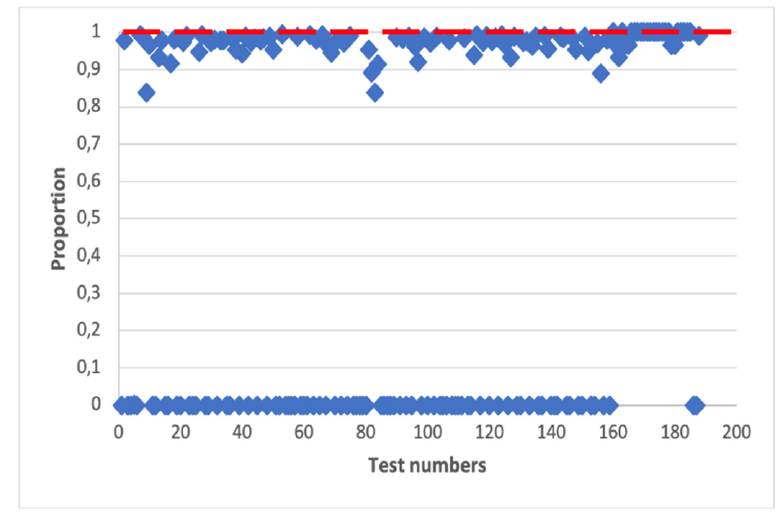
Figure 6. Statistical portrait of the AFG output sequence at p = 137, X (0) = 1.